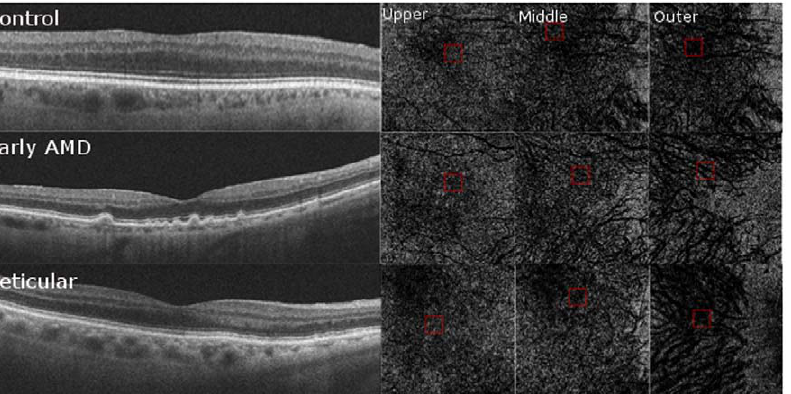
Figure 2. En Face Optical Coherence Tomography (OCT) Choroidal Sub-Layer C-Scans. Examples of 2 micron-thick C-scans obtained from control (top panel), early age-related macular degeneration (AMD, middle panel) and reticular groups (bottom panel). C-scans were obtained from the choriocapillaris or most representative layer below the RPE in the reticular group (center left column), Sattler’s or the middle choroidal layer (center right column), and Haller’s or the outermost layer (far right column) for further analysis.